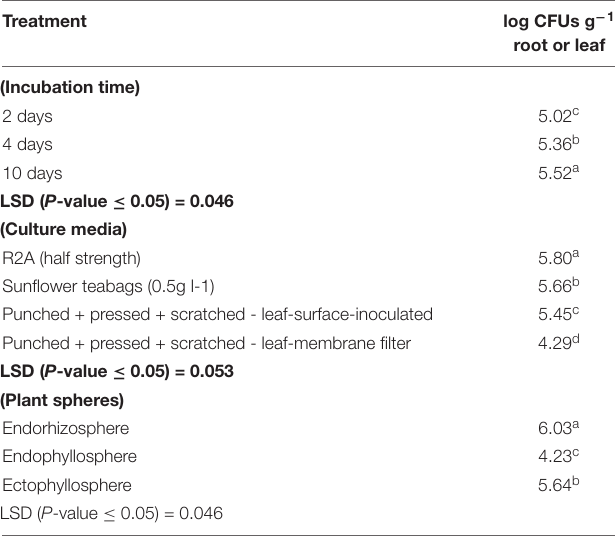
TABLE 2 | One-way ANOVA test of CFU counts of the endorhizosphere, ectophyllosphere, and endophyllosphere from sunflower plants: single effects of incubation time, type of culture media, and plant